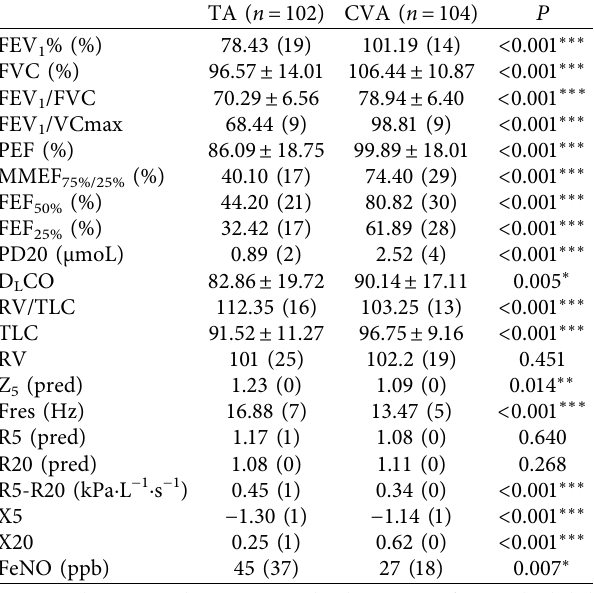
Table 2: Pulmonary function test results of subjects with TA and CVA.